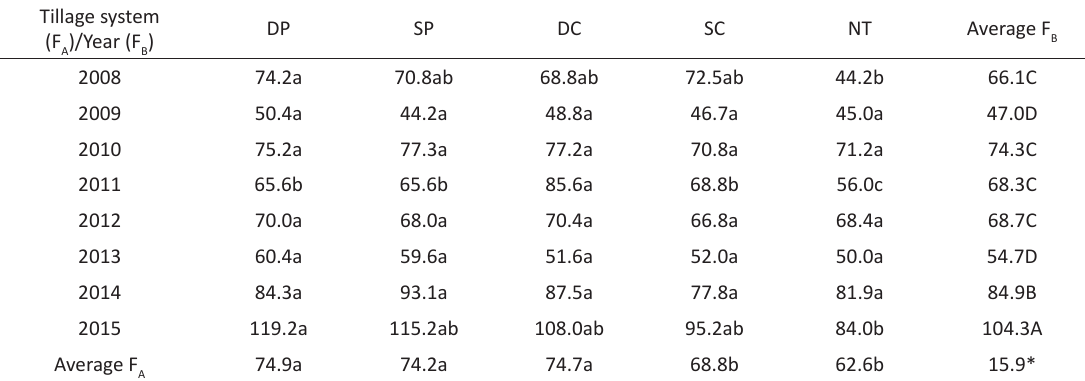
Table 5. The impact of tillage systems on the density of maize crop before the harvest (thousand ha -1 ) Tillage system